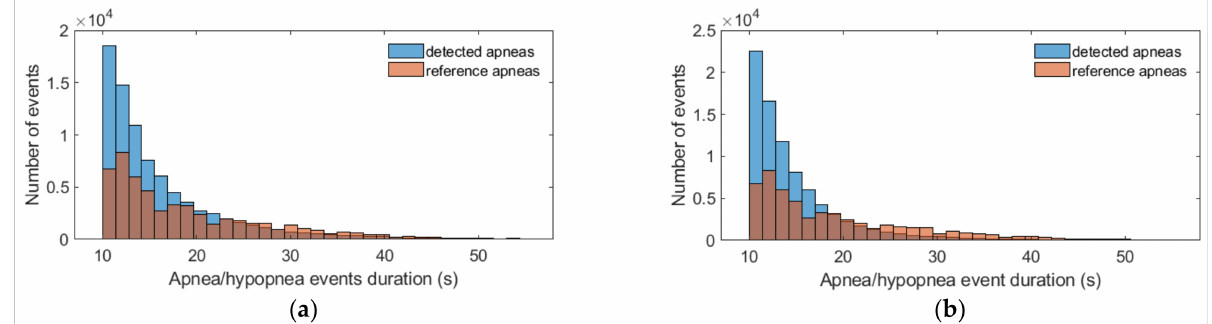
Figure 4. Distribution of the duration of the set of reference apnea/hypopnea events—annotated by the clinical team—and the set of detected apnea/hypopnea episodes. ( a ) Tracheal contact microphone; ( b ) Ambient microphone. Despite the presence of a few events with duration in the range 60–150 s, we opted for presenting only the range 10–60 s to clearly indicate the strong differences between the examined distributions.